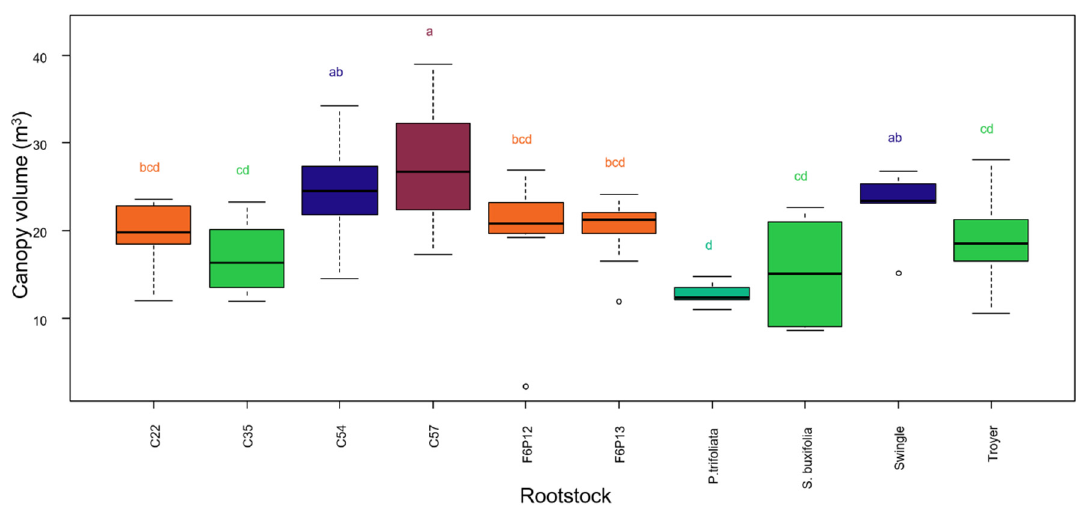
Figure 3. Canopy volume of Mandared grafted onto 10 rootstocks, recorded in spring 2018. Different letters indicate significantly different means according to Tukey’s test at p < 0.05. Different colors of the boxes indicate different significance groups.